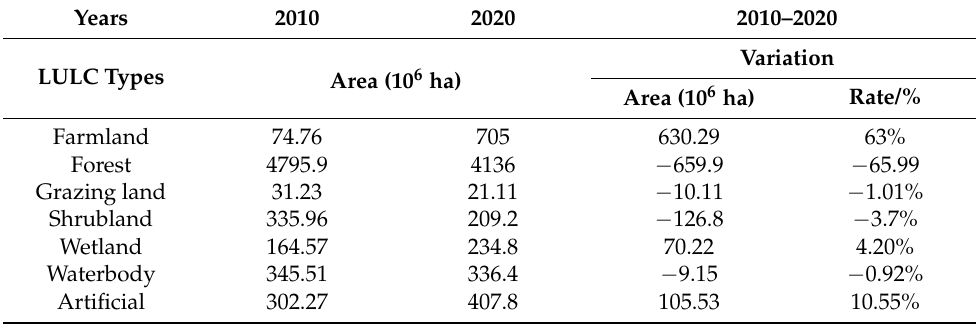
Figure 2. Spatial distribution of land-use and land cover type in Benin tropical coastal zones: ( a ) Spatial distribution in 2010; ( b ) Spatial distribution in 2020. Table 5. Changes in land-use and land cover in Benin tropical coastal area from 2010 to 2020.